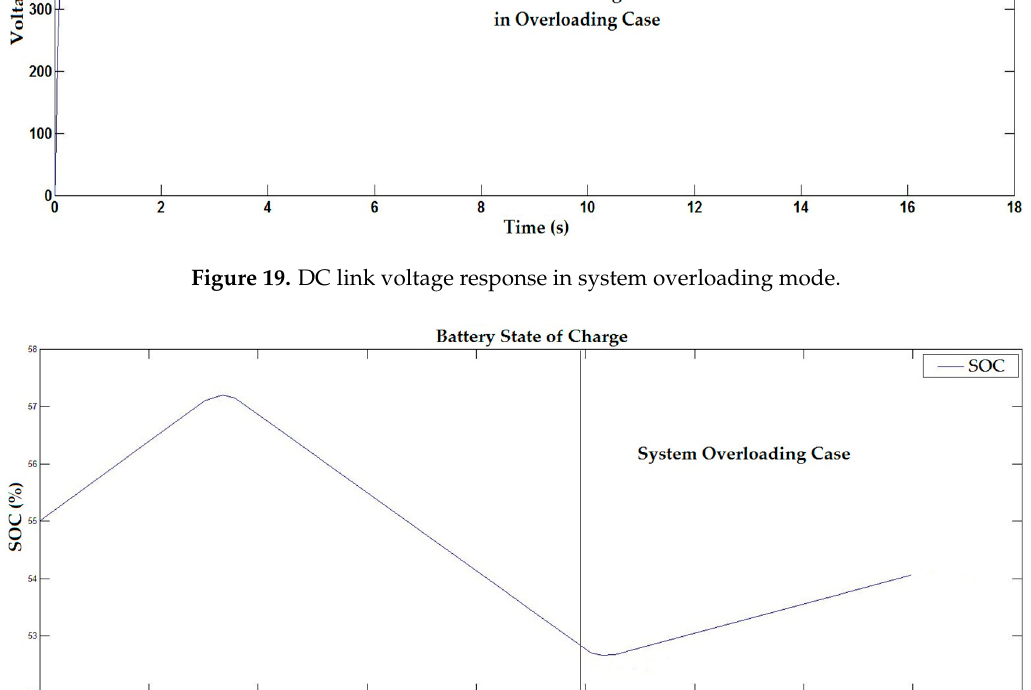
Figure 19 . DC link voltage response in system overloading mode.